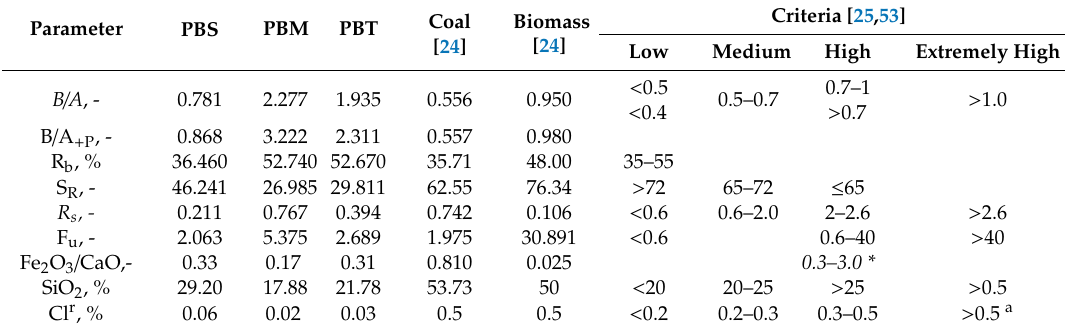
Table 4. Ash deposition indexes and associated